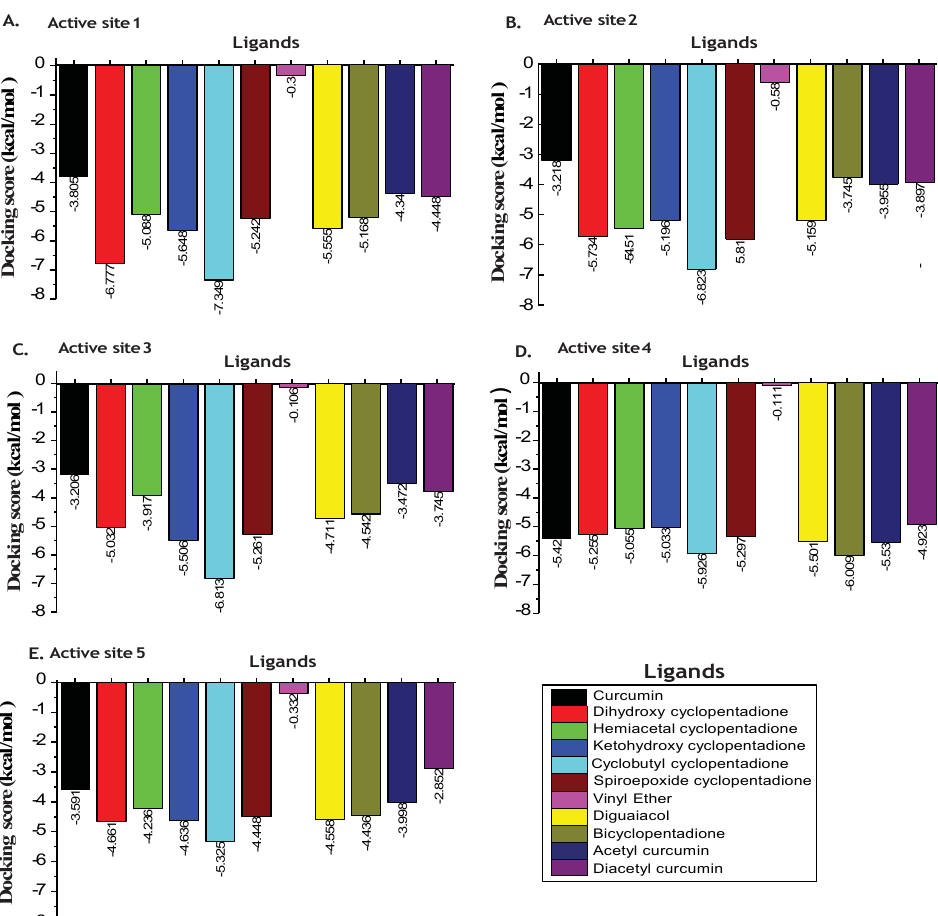
Figure 3. Binding affinity of curcumin and it’s oxidative products to p55 domain of VacA protein. Histogram graphs showing docking scores of curcumin, its oxidative derivatives, and non-oxidizable derivatives with the different binding sites. Different colors represent different ligands. ( A ) Binding affinity of curcumin, its oxidative derivatives, and non-oxidizable derivatives with site 1. ( B ) Binding affinity of curcumin, its oxidative derivatives, and non-oxidizable derivatives with site 2. ( C ) Binding affinity of curcumin, its oxidative derivatives, and non-oxidizable derivatives with site 3. ( D ) Binding affinity of curcumin, its oxidative derivatives, and non-oxidizable derivatives with site 4. ( E ) Binding affinity of curcumin, its oxidative derivatives, and non-oxidizable derivatives with site